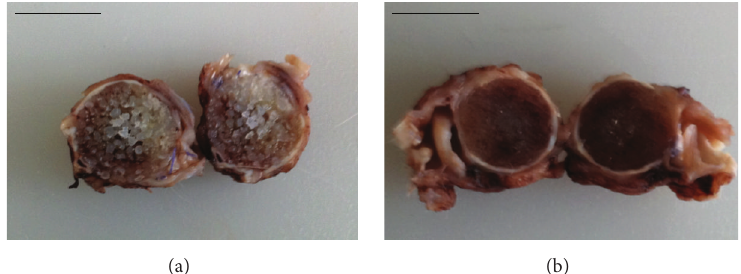
Figure 2: Macroscopic findings at 90 days after orbital implantation. After cutting the eyes through the sagittal plane, the MEDPOR implant (a) appeared as an aggregate of small spherical granules, while OCULFIT I (b), as well as OCULFIT II, was more compact and composed of multiple microgranules. Peripheral ingrowth of host vasculature and soft tissue was present in both materials. Scale bars: 12mm.